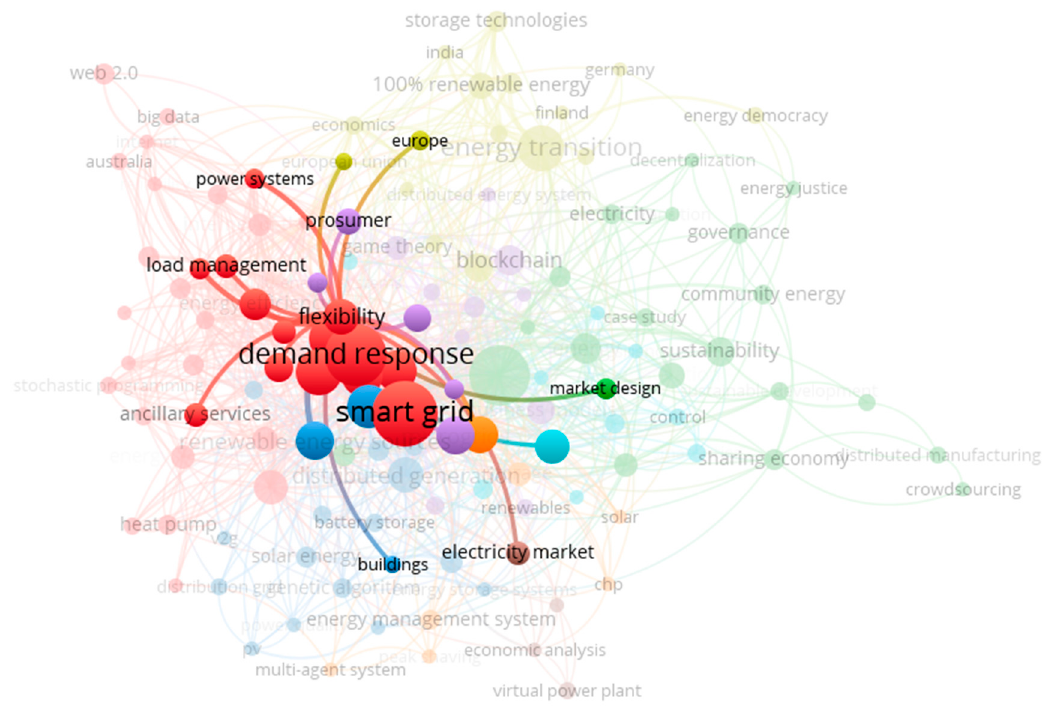
Figure 8. Connections from the term ‘flexibility’.